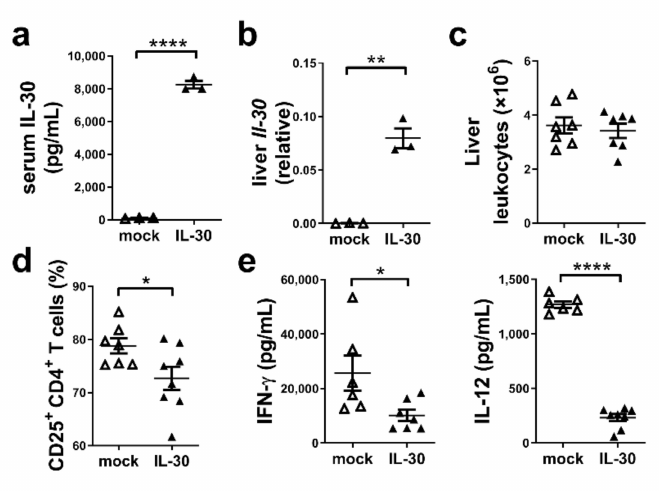
Figure 1. The administration of AAV-mIL-30 reduced the number of CD25 + CD4 + T cells and serum IFN- γ and IL-12 levels in ConA-induced hepatitis mice. Mice were injected with ConA for the induction of hepatitis. AAV-mock or AAV-mIL-30 were administered 5 days before ConA injection. Sera and liver tissues were collected at 4 h after ConA injection. ( a ) Serum levels of IL-30 were detected using ELISA. ( b ) Liver IL-30 mRNA expression was detected using RT-qPCR. Relative quantification was performed with the 2 − ∆ CT method. ( c ) The number of liver leukocytes was counted. ( d ) The level of CD25 expression on CD4 + T cells was analyzed using flow cytometry. ( e ) Serum levels of IFN- γ and IL-12 were detected. Each dot represents an individual mouse. n = 3–7 mice per group. All error bars denote ± SEM. *, p < 0.05; **, p < 0.01; ****, p <